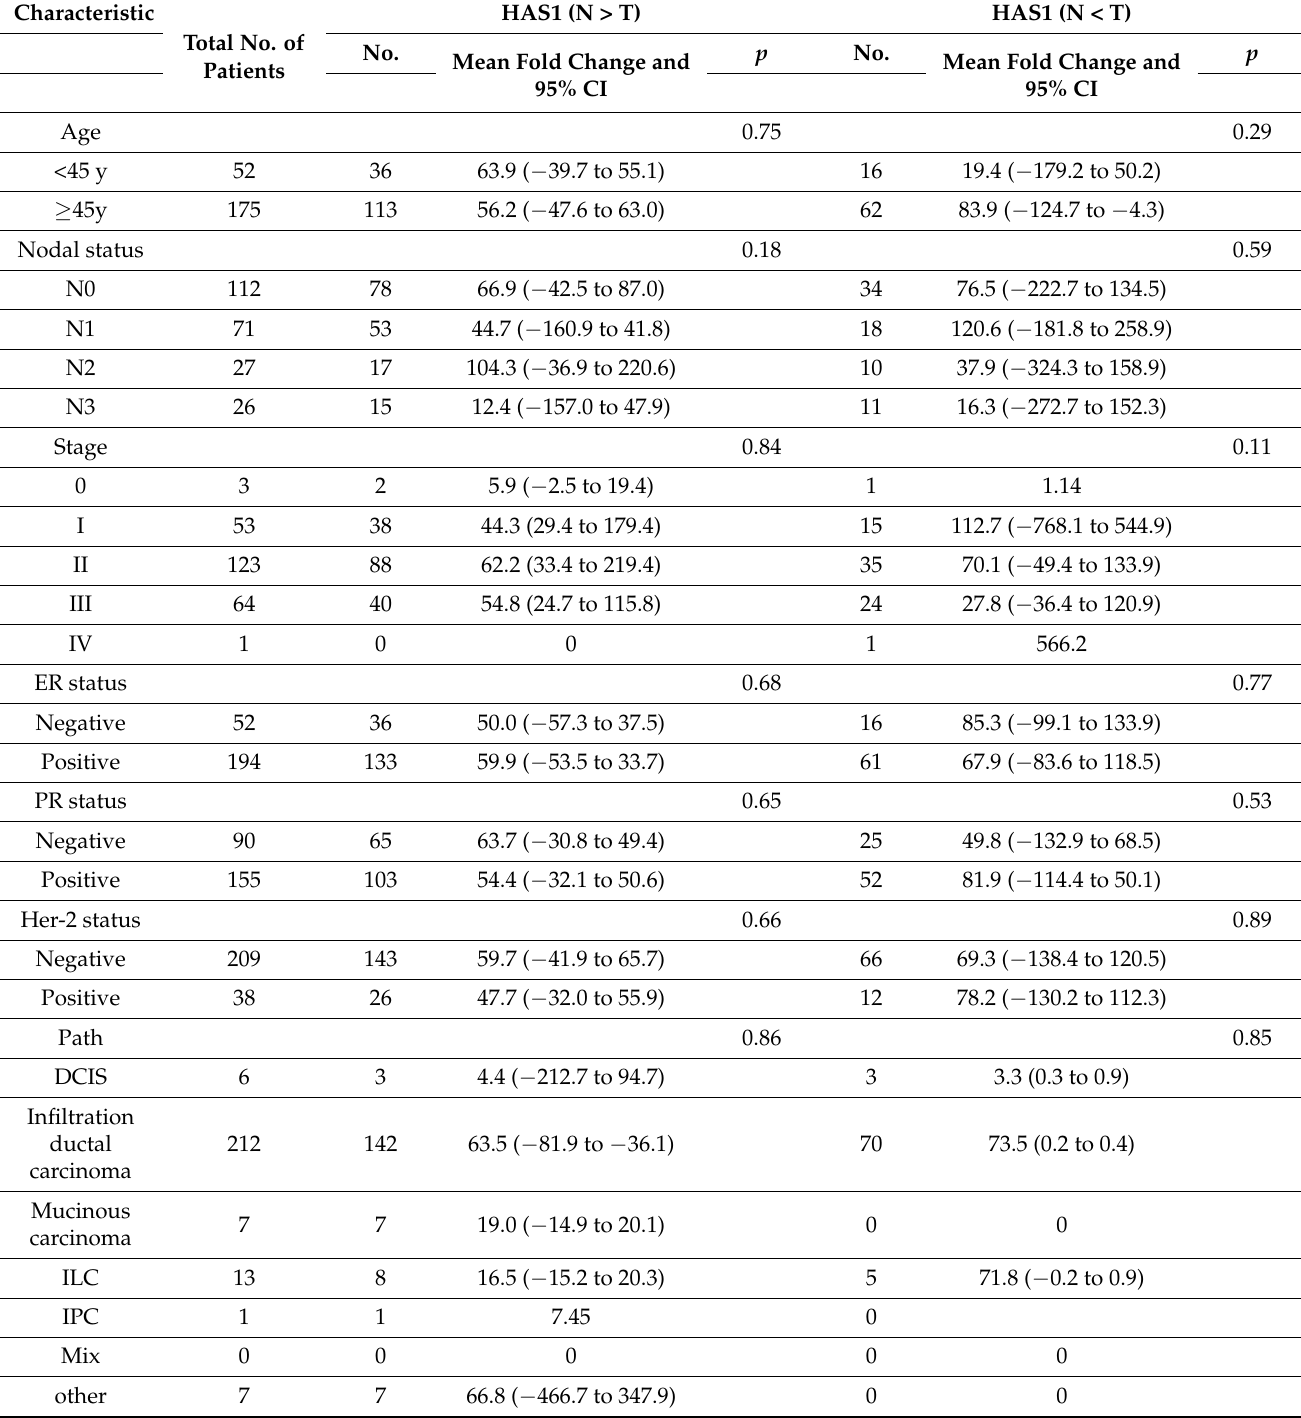
Table 3. Demographic evaluation of clinical criteria and HAS1 mRNA expression fold changes between tumor vs. normal paired